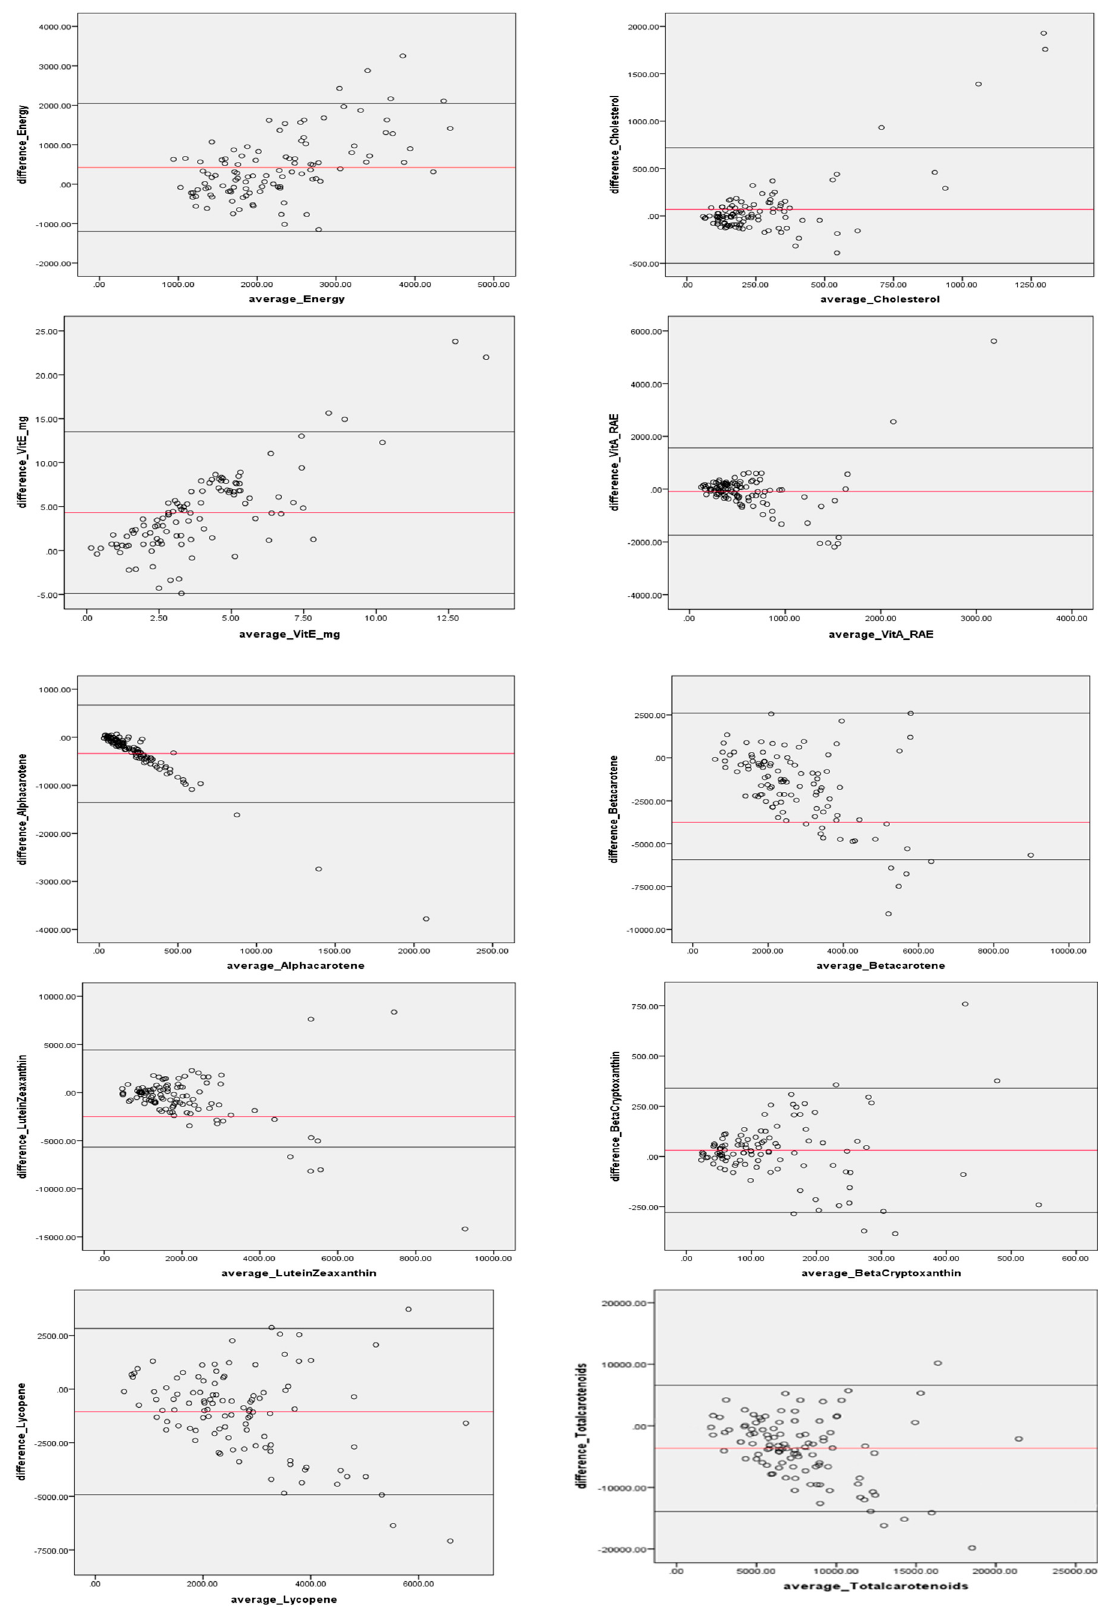
Figure 2. Bland–Altman plots for energy and select nutrients ( n = 107).